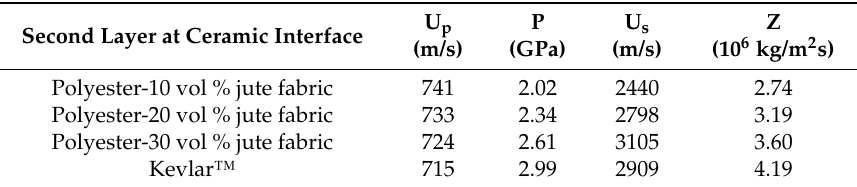
Table 2. Calculated parameters for the impedance matching analysis.